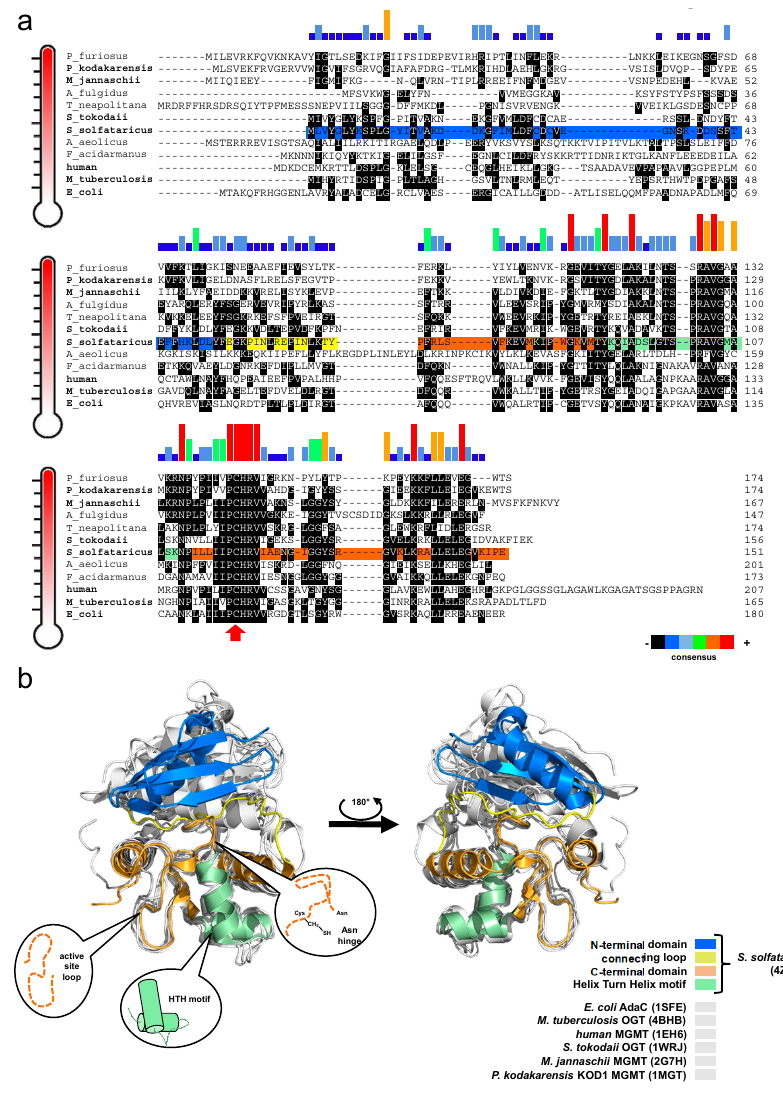
Figure 2. ( a ) Alignment of biochemically and structurally (in bold) characterized AGTs. DNA sequences are listed in decreasing order of temperature. The histograms in di ff erent colours show the sequence consensus, and the red arrow indicates the highly conserved catalytic cysteine. ( b ) Superimposition of all known AGT structures in their free form (in grey). All common domains and elements are coloured only for the O 6 -alkyl-guanine-DNA-alkyl-transferase protein from the archaeon Saccharolobus solfataricus (hereinafter Ss OGT) enzyme. Coloured bars behind the Ss OGT sequence in ( a ) recall the enzyme domains highlighted in the structure and in the legend in ( b